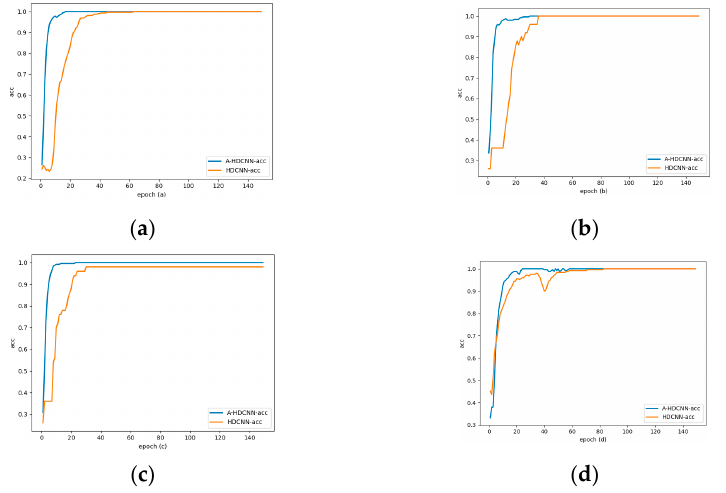
Figure 12. Accuracy rate change curve: ( a ) 𝐴 − 𝐻𝐷𝐶𝑁𝑁 (cid:2869)(cid:2869) and 𝐻𝐷𝐶𝑁𝑁 (cid:2869)(cid:2869) accuracy rate change curve; ( b ) change in accuracy of 𝐴 − 𝐻𝐷𝐶𝑁𝑁 (cid:2869)(cid:2870) and 𝐻𝐷𝐶𝑁𝑁 (cid:2869)(cid:2870) ; ( c ) change in accuracy of 𝐴 − 𝐻𝐷𝐶𝑁𝑁 (cid:2870)(cid:2870) and 𝐻𝐷𝐶𝑁𝑁 (cid:2870)(cid:2870) ; ( d ) change in accuracy of 𝐴 − 𝐻𝐷𝐶𝑁𝑁 (cid:2871)(cid:2870) and 𝐻𝐷𝐶𝑁𝑁 (cid:2871)(cid:2870) .